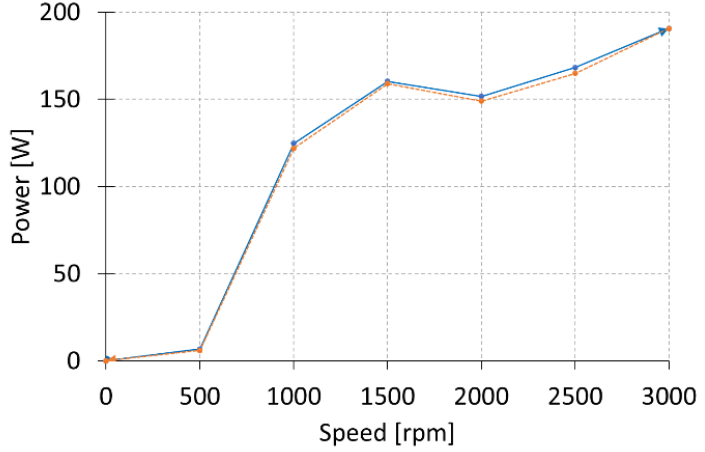
Figure 5. Hysteresis of the motor-pump unit (MPU) power consumption at different rotational speeds.